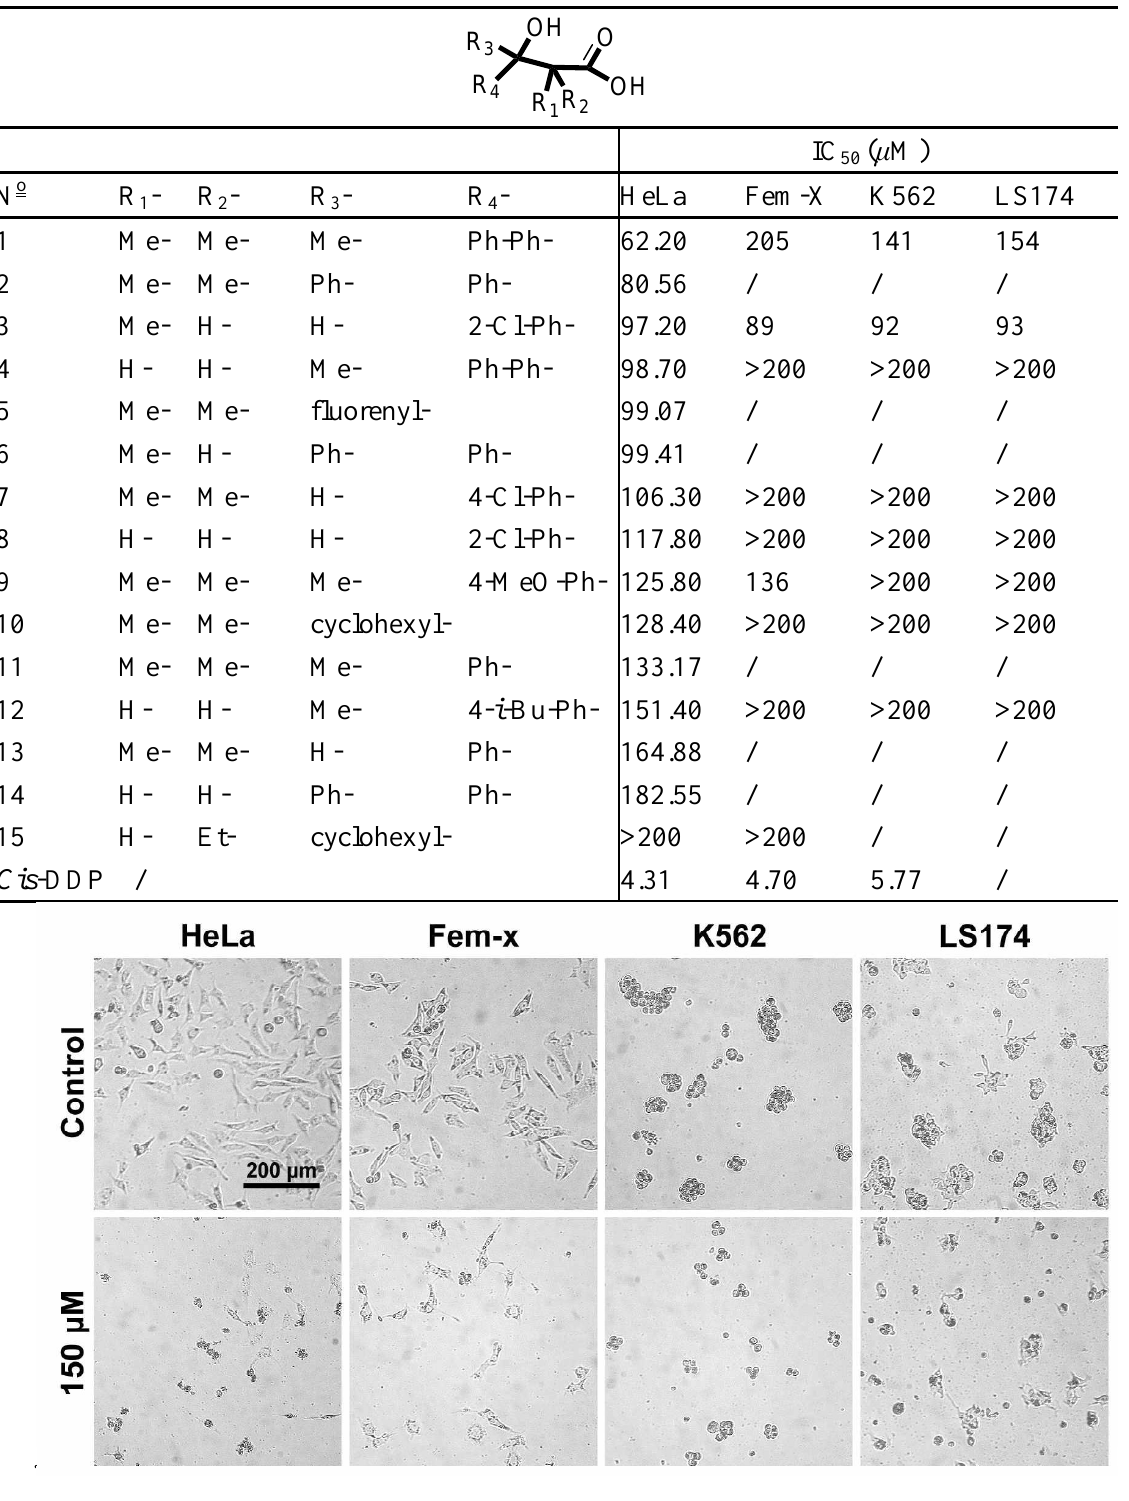
Table 1. Structures and IC values of studied b -hydroxy- b -arylalkanoic acids toward HeLa, Fem-X, 50 K562, LS174. cis -Diammindichloro platinum (cisplatin, cis -DDP) was used as a positive control.